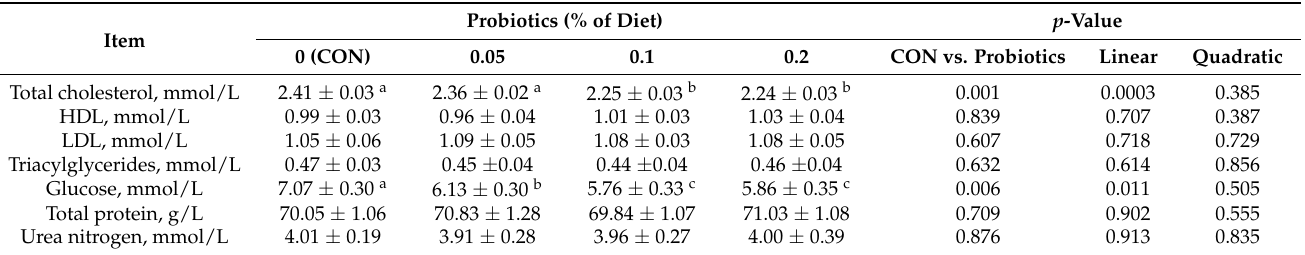
Table 5. Effects of dietary complex probiotic supplementation on the blood profile in growing